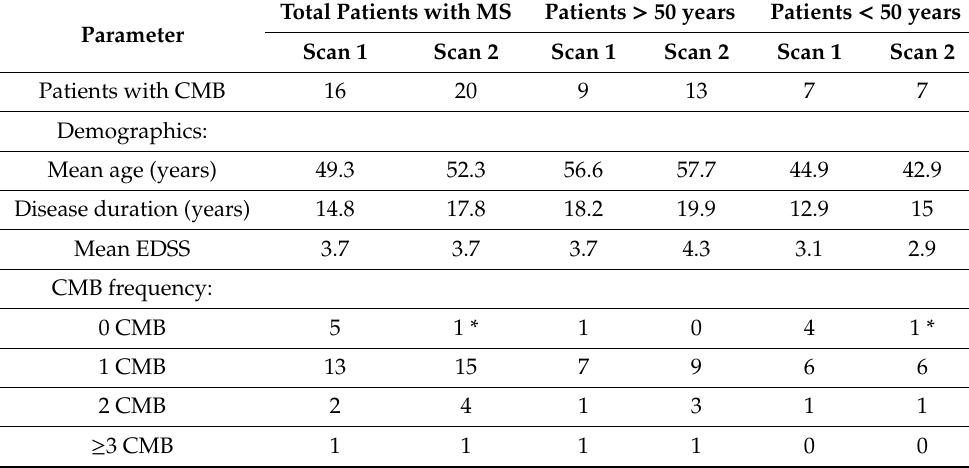
Figure 2. ( A , B ) represent the magnitude and iSWIM MIP (over 5 slices) images, respectively, for the first scan while ( E , F ) represent the matching images for the follow-up scan, respectively. The CMB is labeled with the white arrow and appears hypo-intense in magnitude and hyper-intense in the iSWIM MIP, indicating it is paramagnetic. The second scan images ( E , F ) show an increase in size and intensity of the bleed which indicates that there was further bleeding over time. ( C , D ) represent the magnitude and iSWIM MIP (over 5 slices) images for the first scan of a different subject while ( G , H ) represent the matching images for the follow-up scan. The white arrows point to a bleed which appears hypo-intense in magnitude and hyper-intense in the iSWIM MIP at both time points. The dotted arrows in the second scan ( G , H ) depict a new bleed that developed after the first scan. Table 4. CMB prevalence in patients with MS (cohort 2).